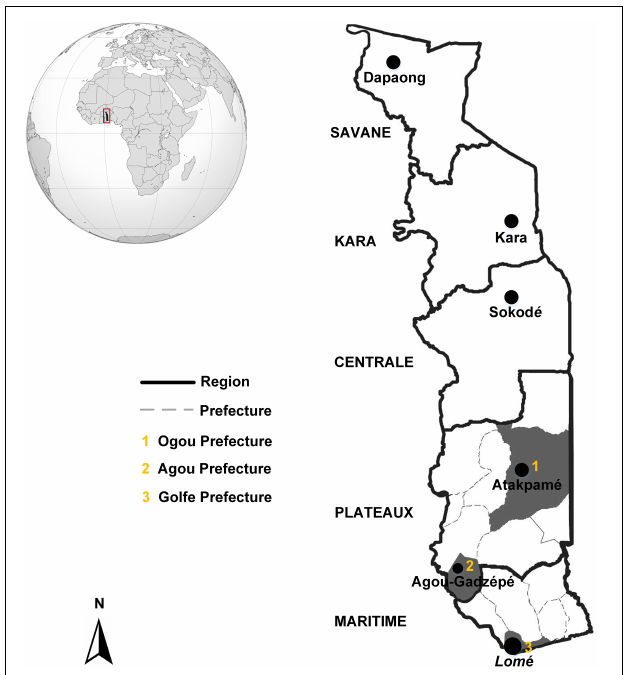
FIGURE 1 | Togo, showing the geographic area of the municipalities involved in this study (dark gray shading). Atakpamé (Ogou Prefecture), Agou-Gadzépé (Agou Prefecture), and Lomé (Golfe Prefecture) are located in the Plateaux and Maritime Regions,